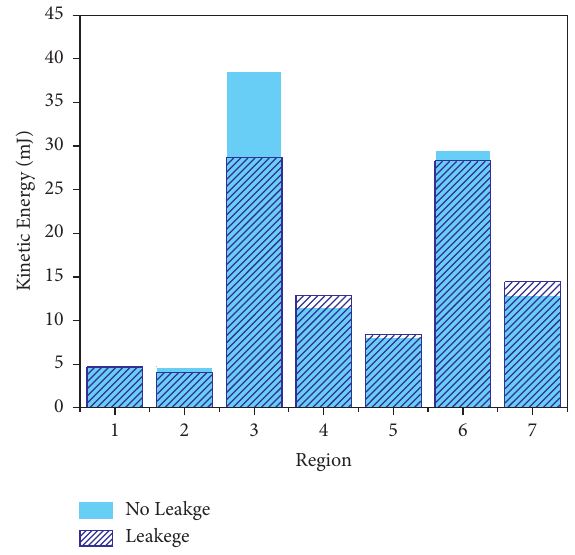
Figure 10: Average kinetic energy of particles in each region in a leak and nonleak situation. Table 5: Total collision count within 1.0–1.2 s of the simulation. Without